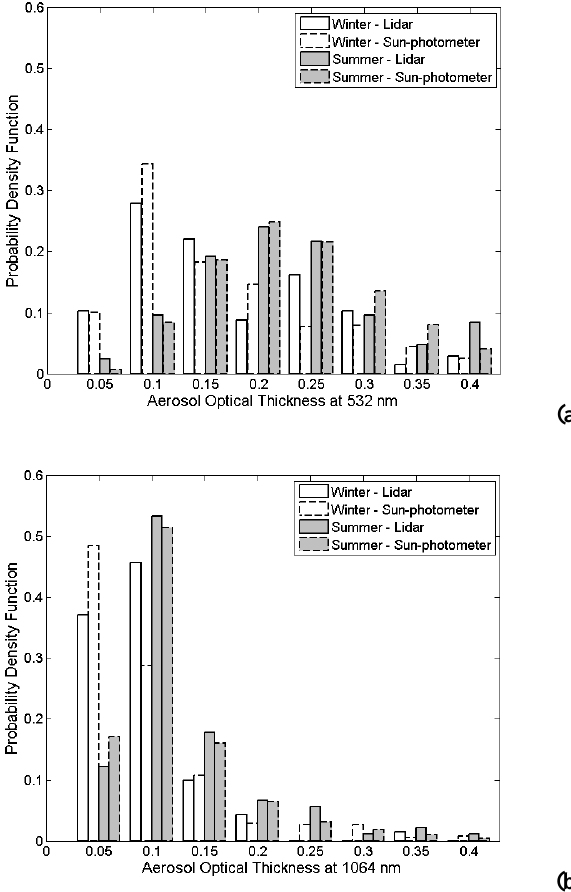
Fig. 1. Sun-photometer- and lidar-derived AOT probability density function for winter (October – March) and summer (April – September) (a) at 532 nm and (b) at 1064 nm.